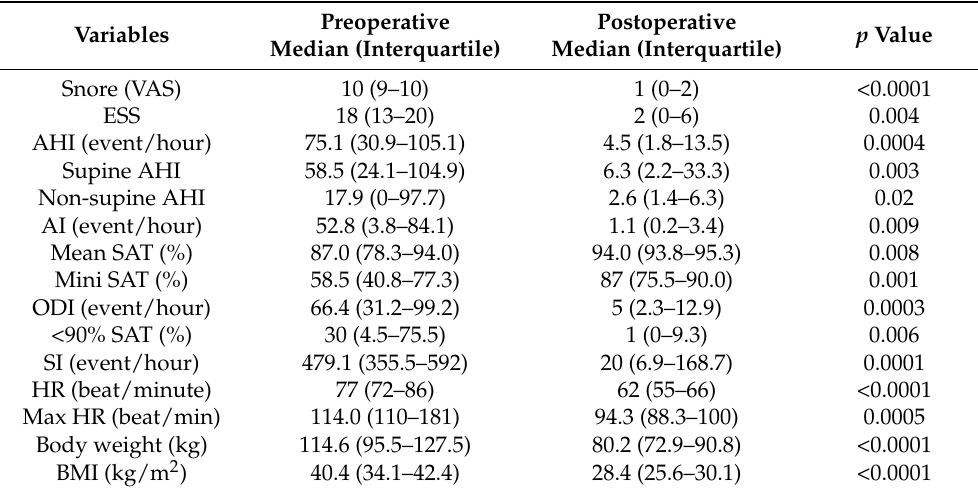
Table 2. Changes in polysomnographic and anthropometric data after CABS.